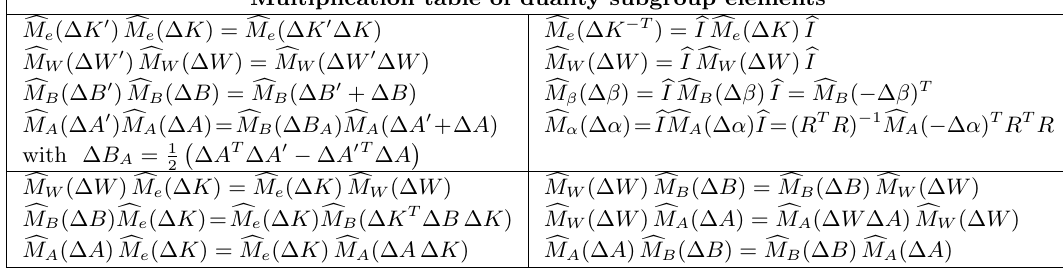
Multiplication table of duality subgroup elements